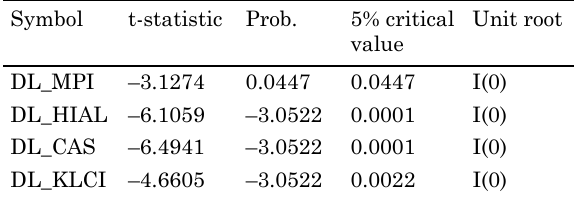
Table 5. Augmented Dicker-Fuller unit-root